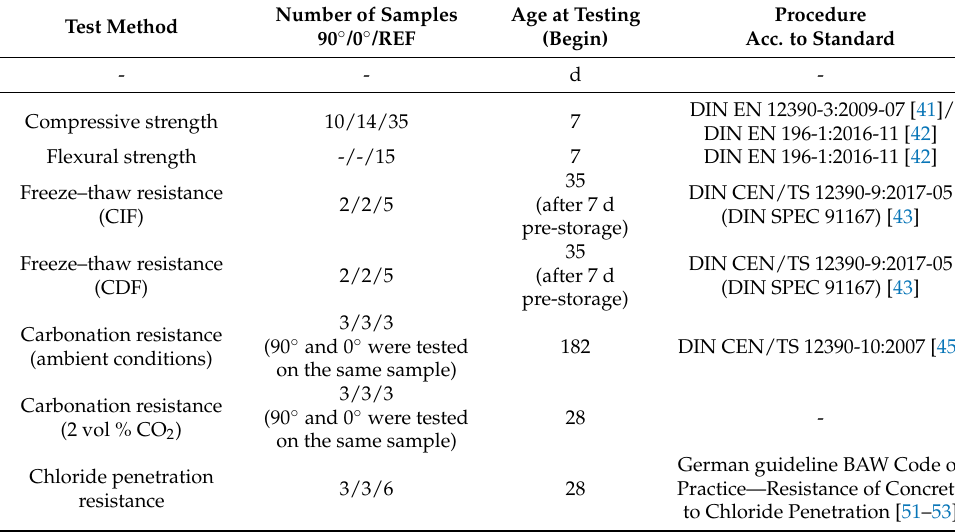
Table A2. Summary of strength and durability